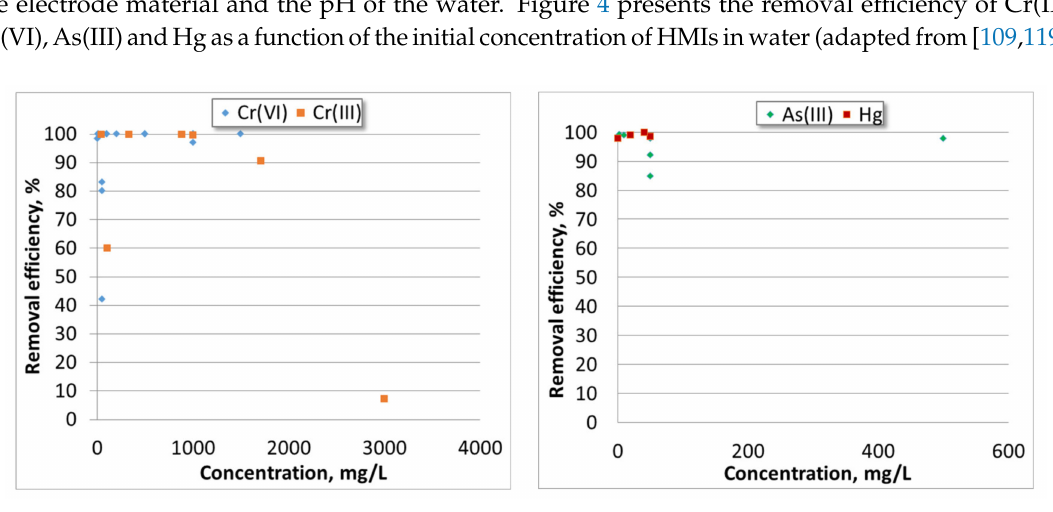
Figure 4. Removal e ffi ciency of Cr (III), Cr (VI), As (III) and Hg function of the initial concentration of ions in the